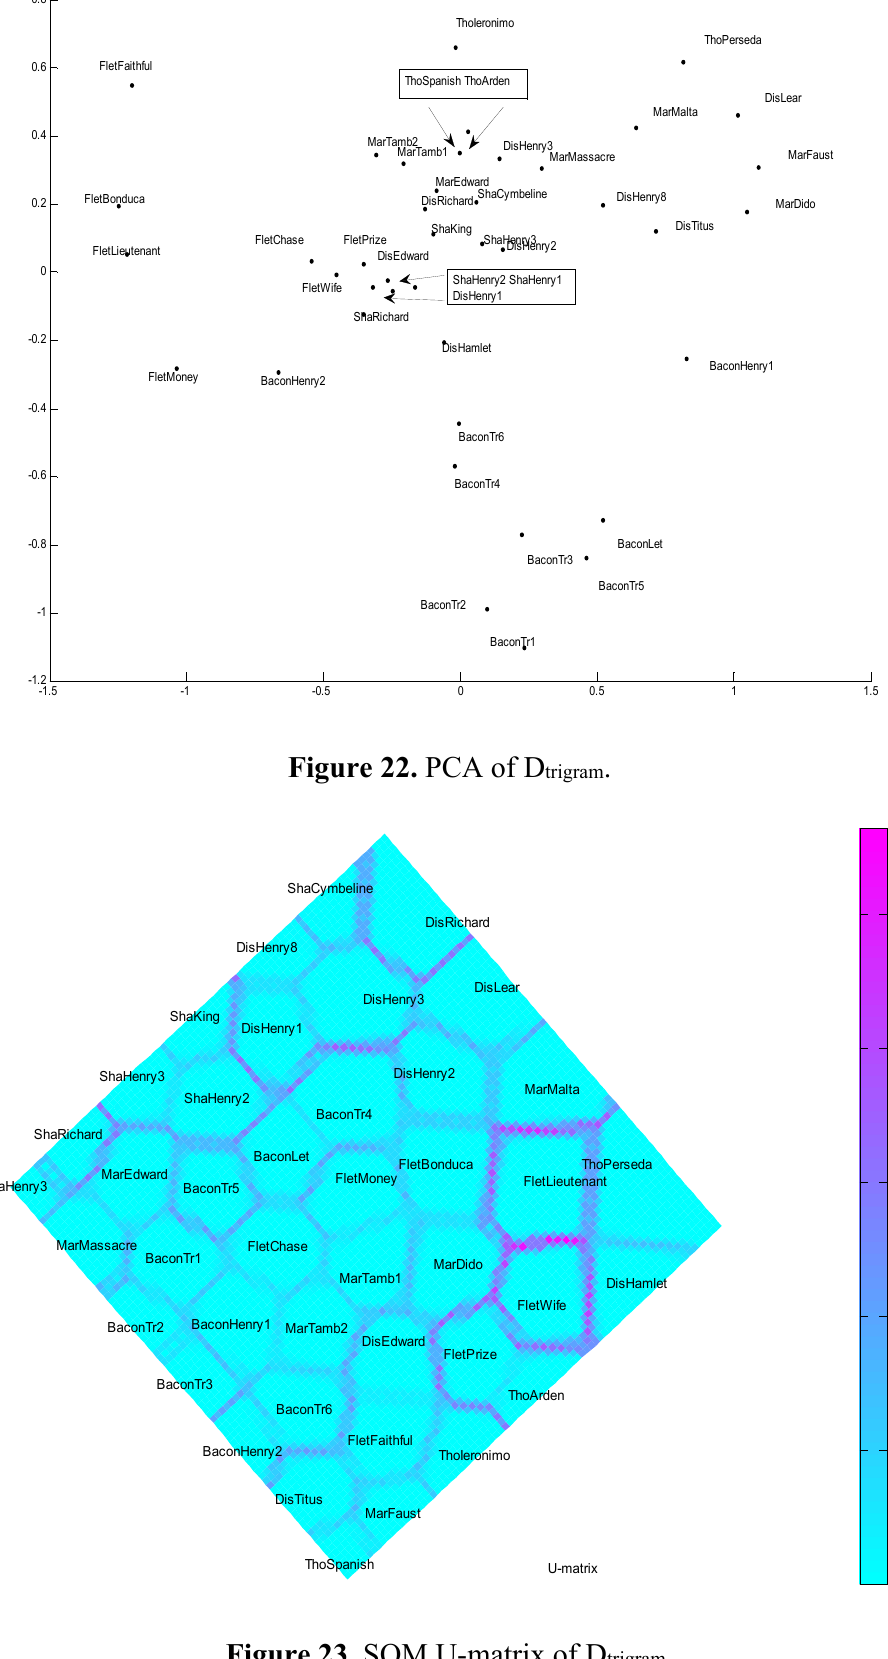
Figure 23. SOM U-matrix of D trigram